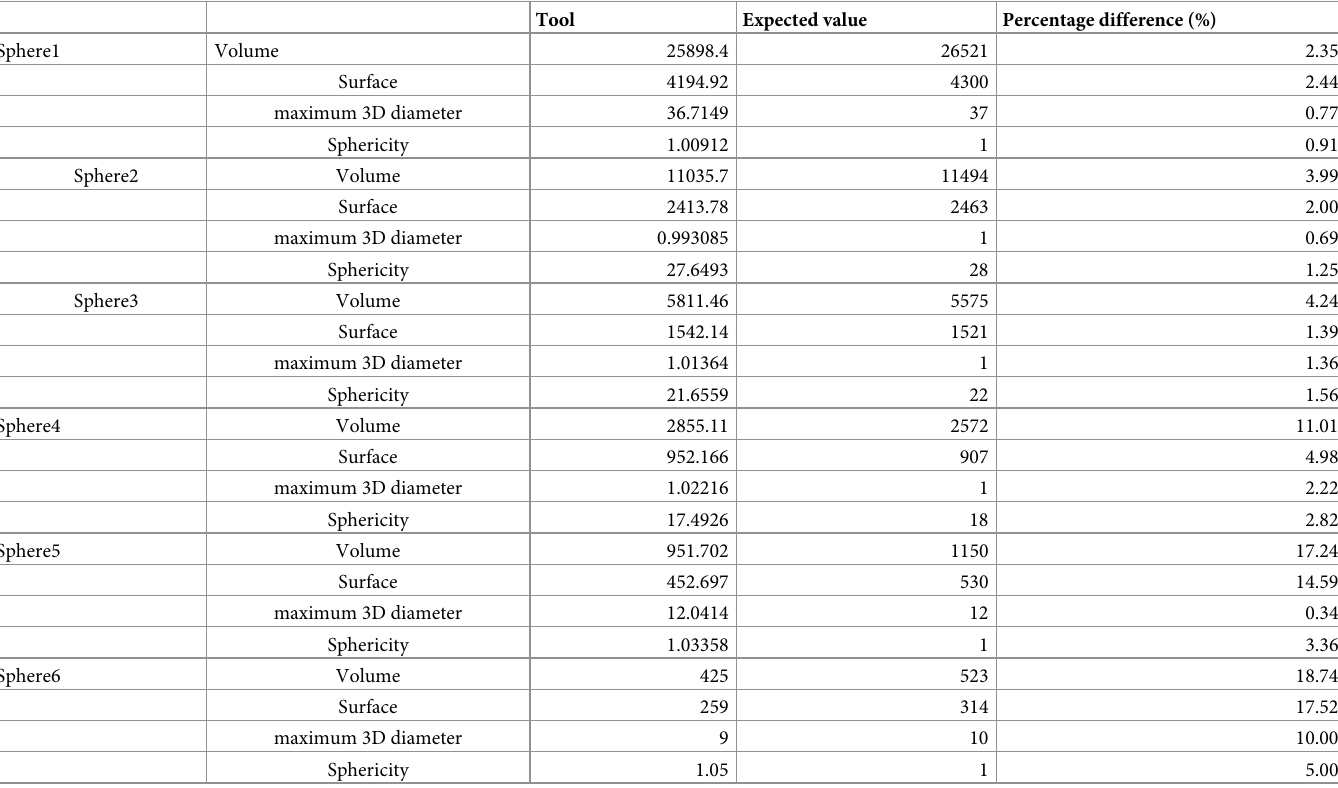
Table 3. Morphological features calculated by RaCaT, the expected value, and the percentage differences between these two values for the spheres of the NEMA image quality phantom.